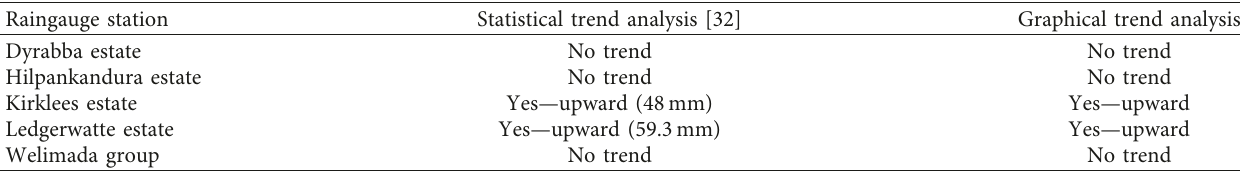
Figure 2: Graphical trends for annual rainfalls for Uma Oya catchment. (a) For Dyrabba estate. (b) For Hilpankandura estate. (c) For Kirklees estate. (d) For Ledgerwatte estate. (e) For Welimada Table 2: Comparison results for annual rainfalls for Uma Oya catchment.